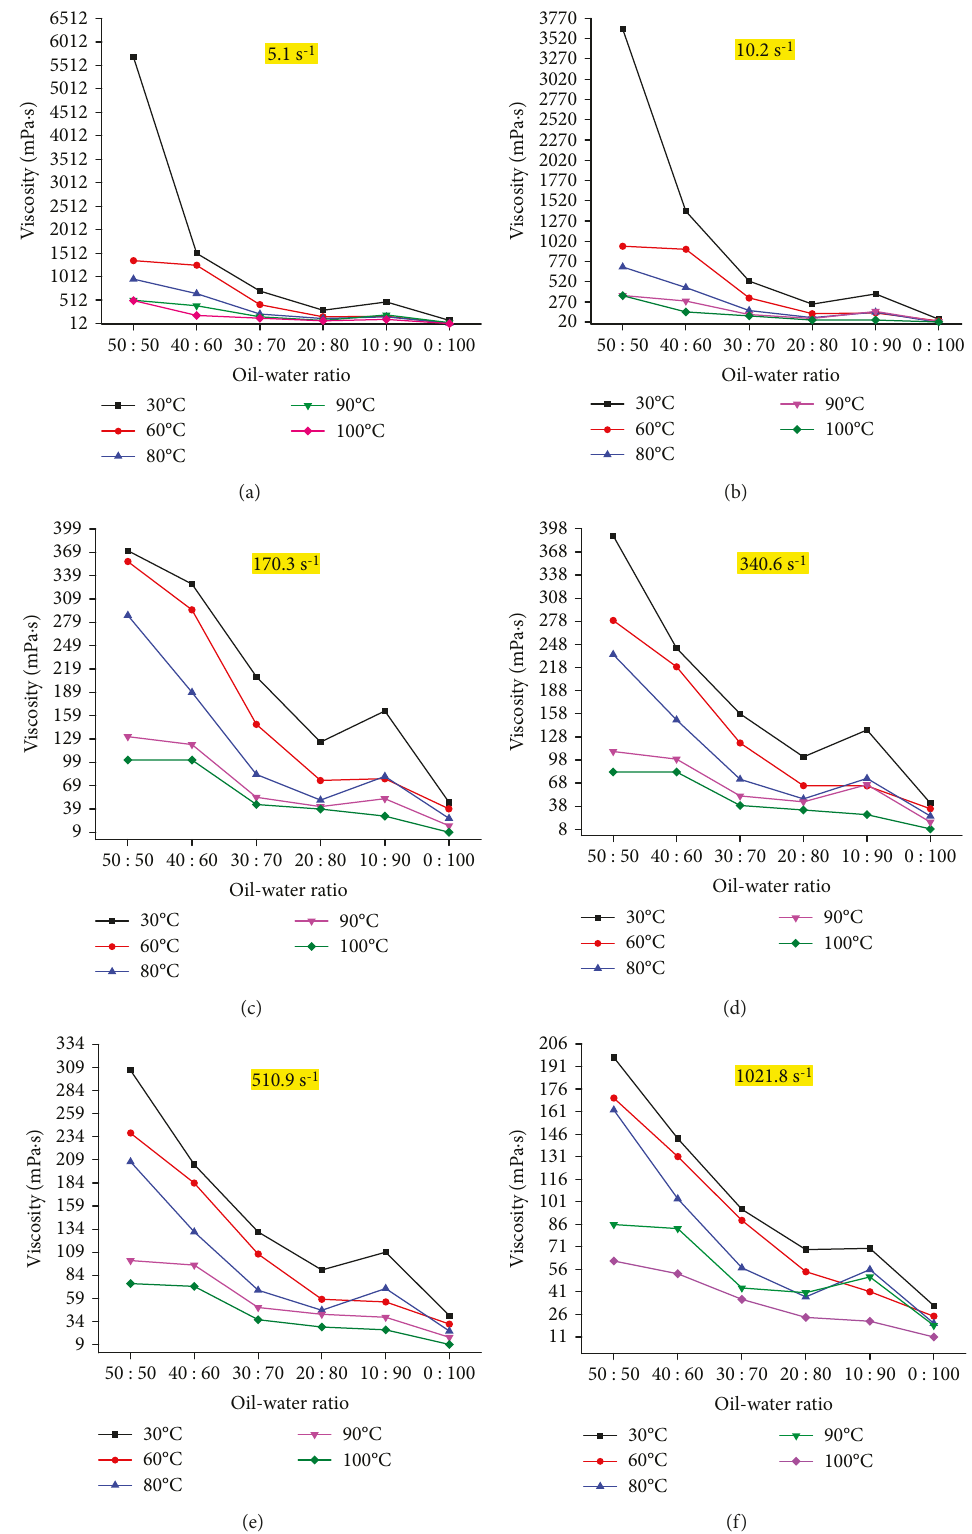
Figure 2: The relationship between the oil-water ratio and viscosity under di ff erent shear